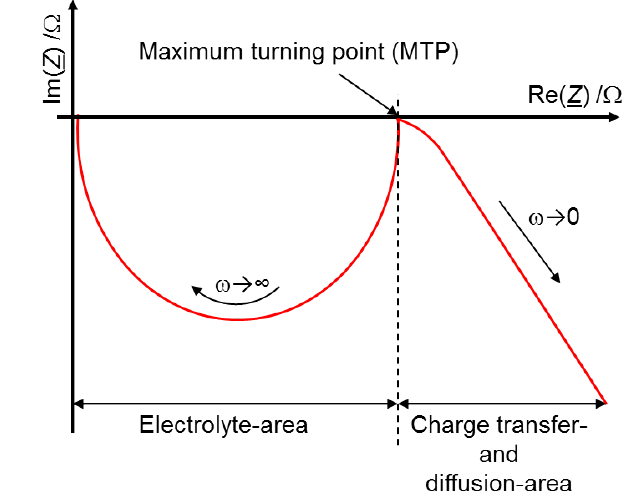
Figure 4. Qualitative plot of an impedance spectra.